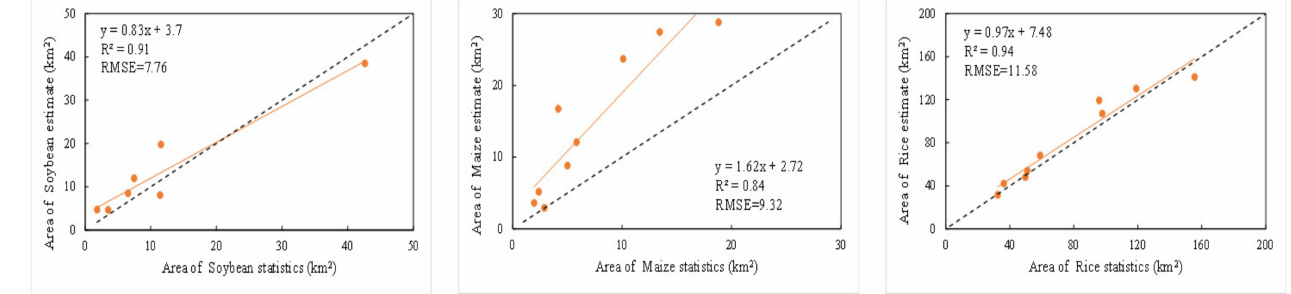
Figure 10. Correlation of the model − estimated main crop area with the statistical area in 2018.